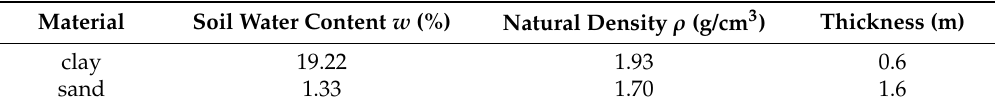
Table 2. Physical indexes of soil